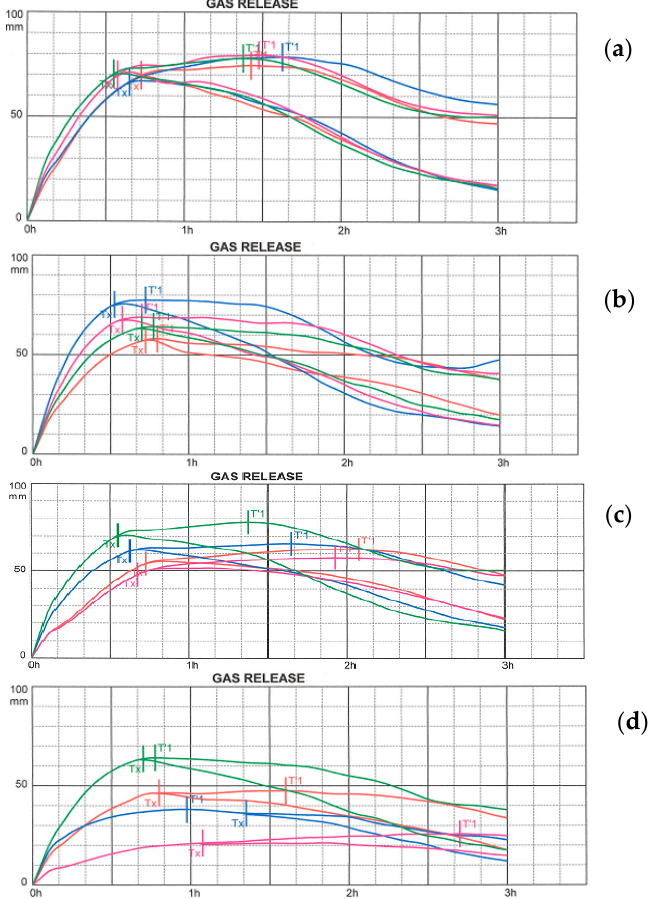
Figure 6. Rheofermentometer curve ( a ) addition of chickpea flour; ( b ) addition of red lentil flour; ( c ) addition of common bean flour; ( d ) addition of broad bean flour. Green—WF(50) + RF(50); Red–addition of 5%; Blue—addition of 10%; Purple—addition of